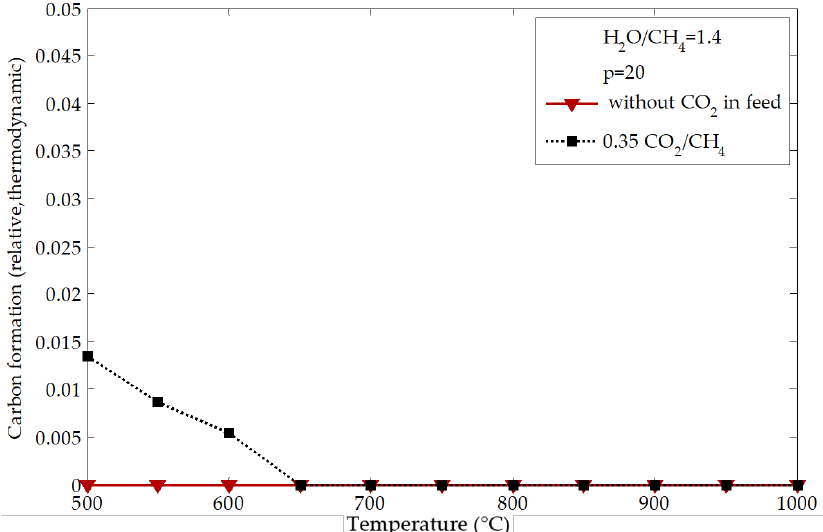
Figure 4. Carbon formation over temperature without CO 2 and with 0.35 CO 2 /CH 4 at the inlet. Comparison of Results with Data by Sun, et al. [20]